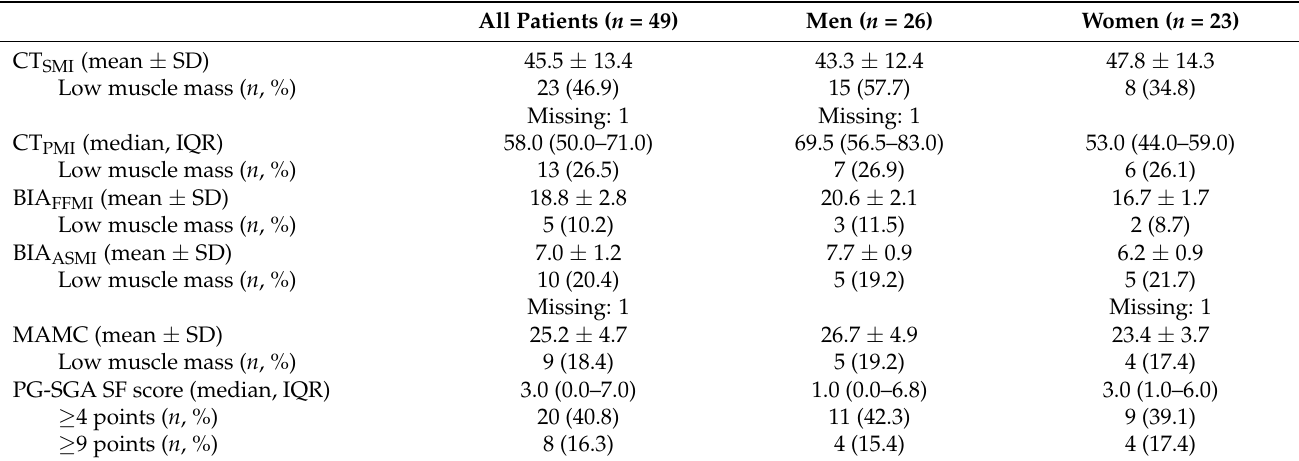
Table 2. Measurements of muscle mass and PG-SGA